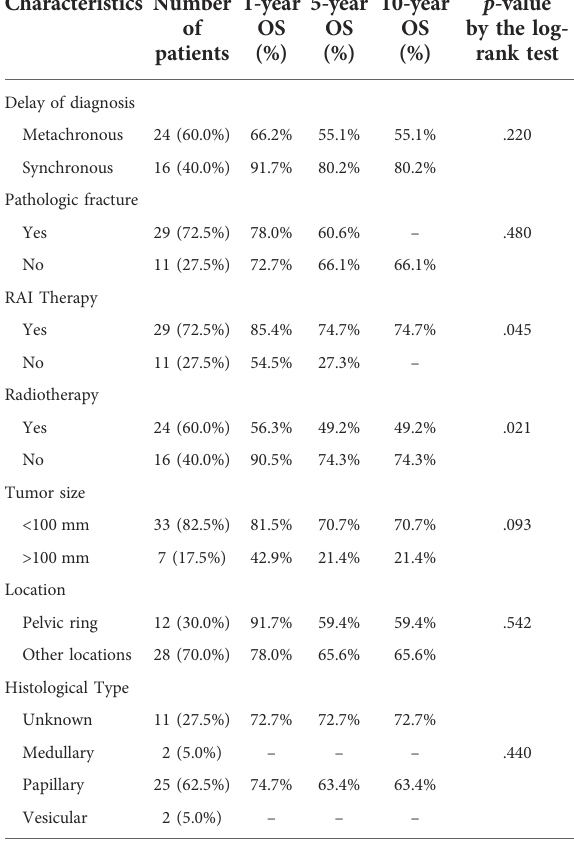
TABLE 3 Univariate log-rank analysis of the overall survival (OS) for the whole series. Characteristics Number of